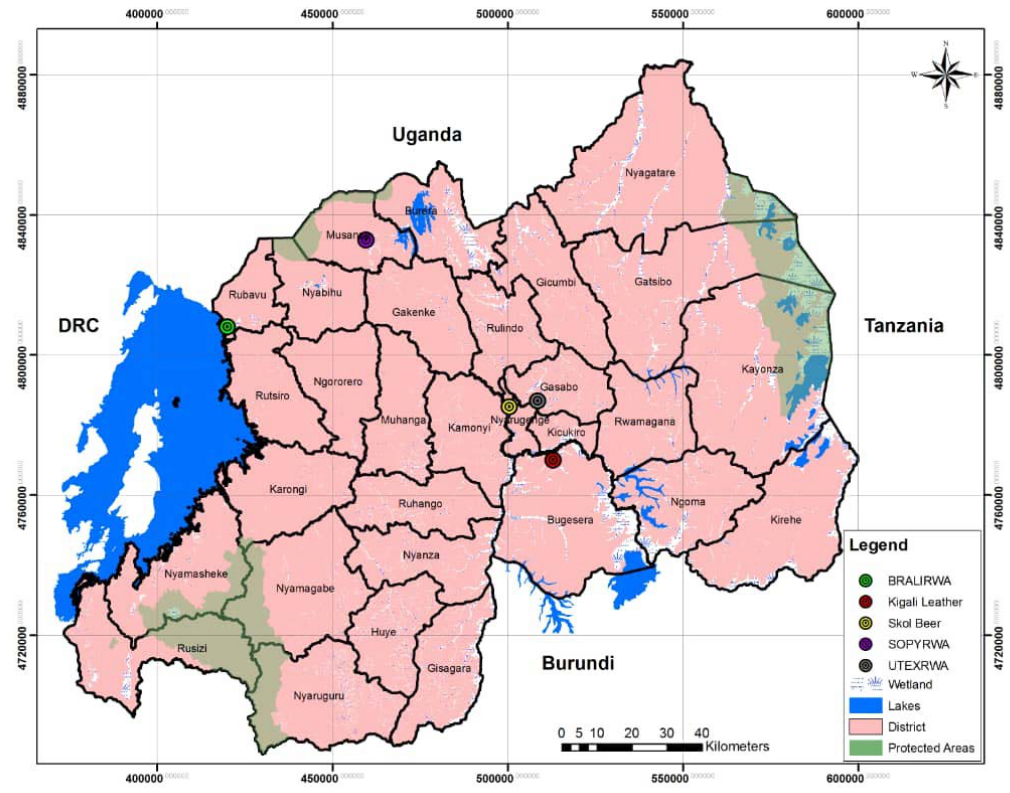
Figure 1. Map of Rwanda, showing the selected industries’ locations.